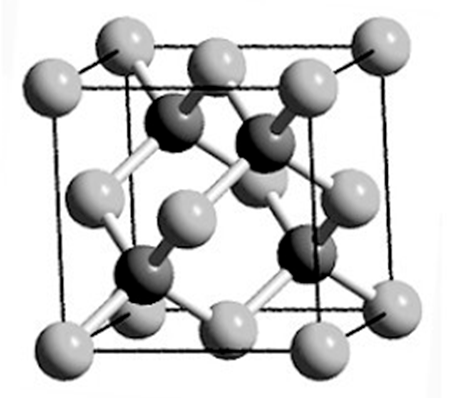
Figure 8. Diamond cell with a face-centered cubic structure [80].